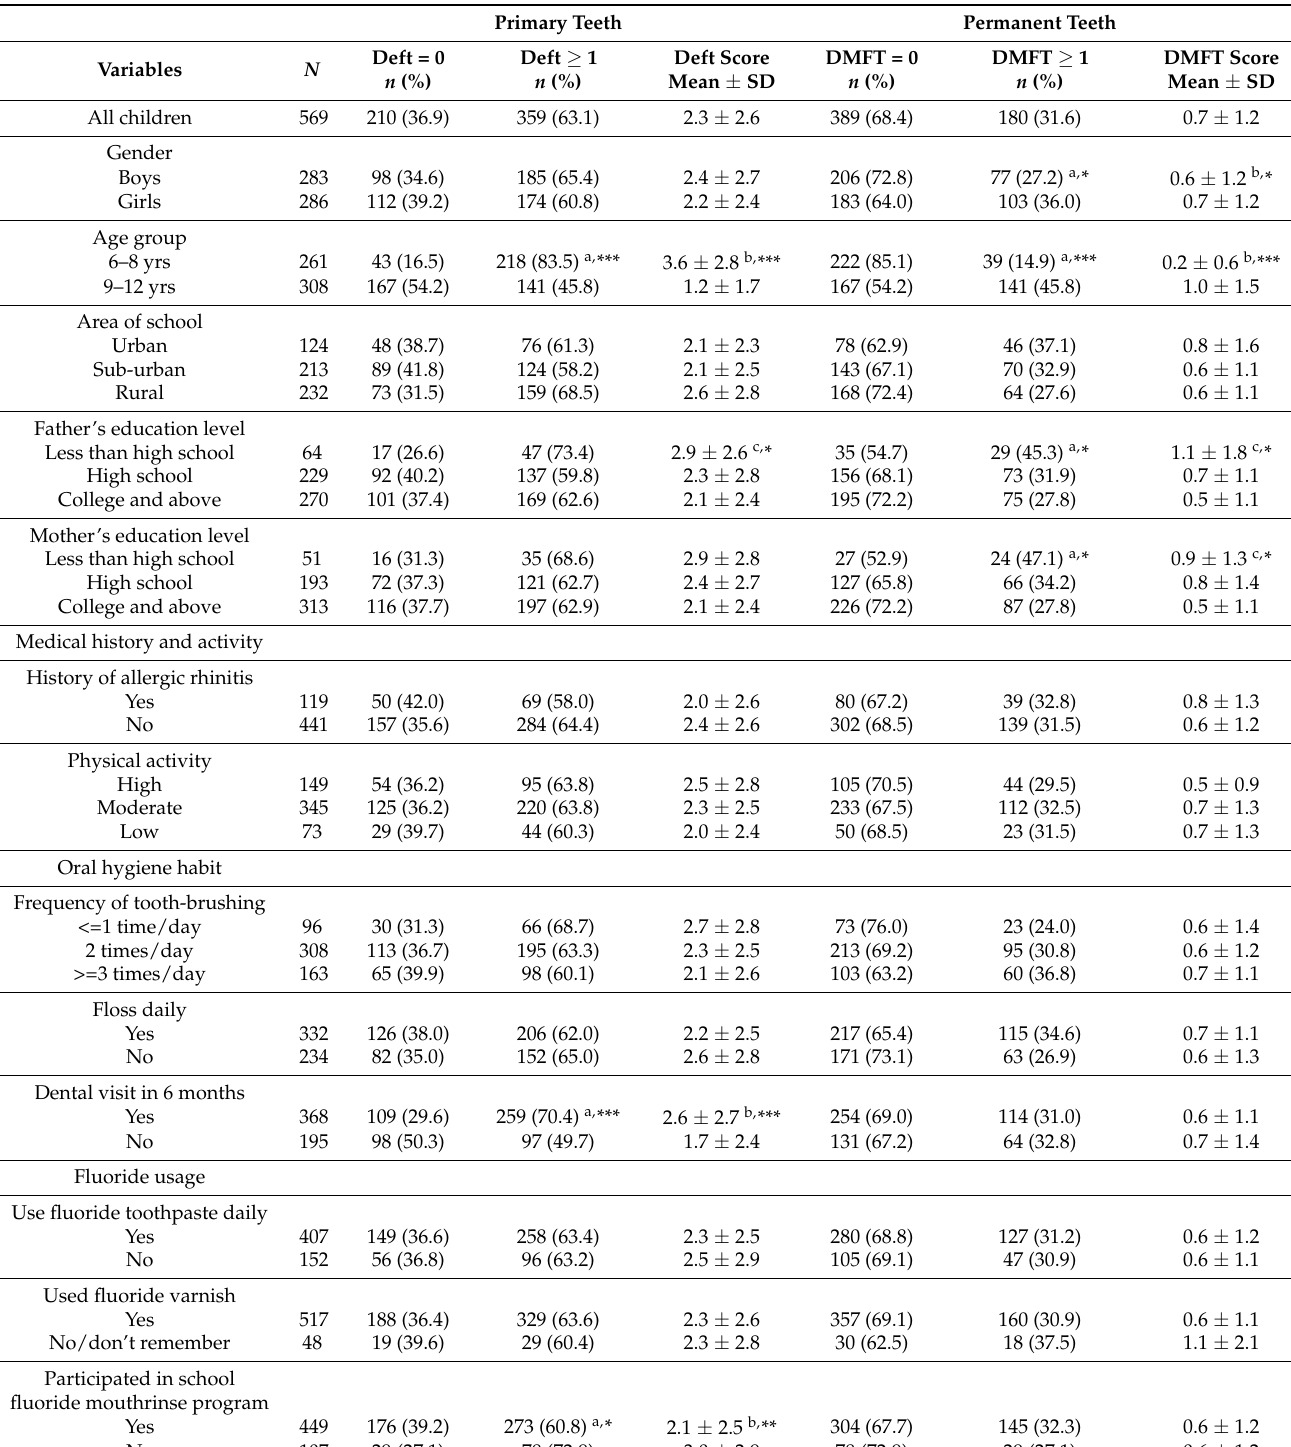
Table 1. Demographic characteristics, oral health habits, fluoride use, and dental caries experience of participating